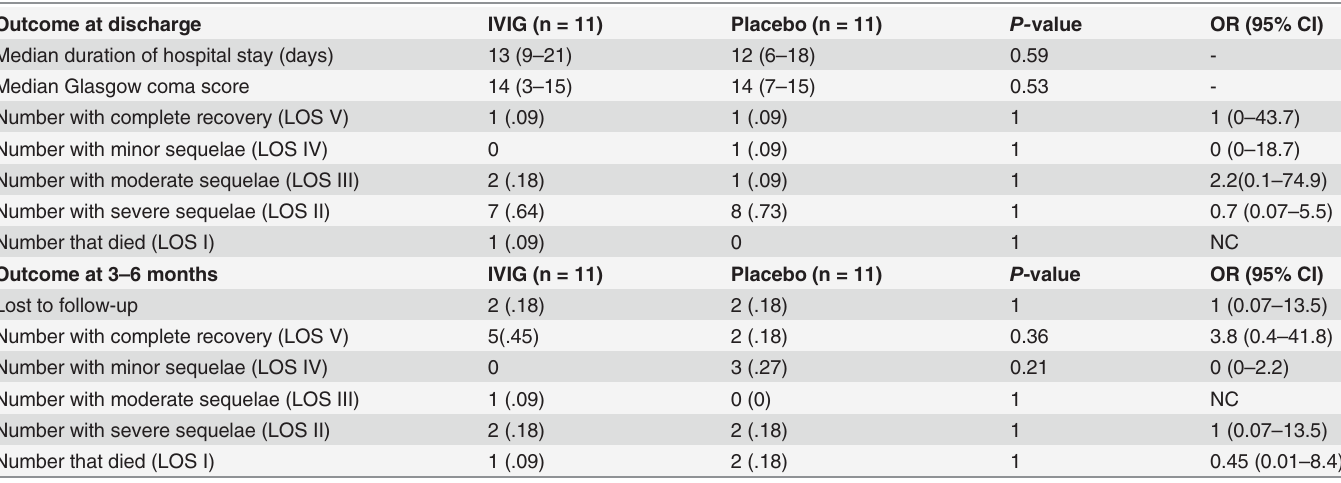
Table 3. Outcome for trial participants.